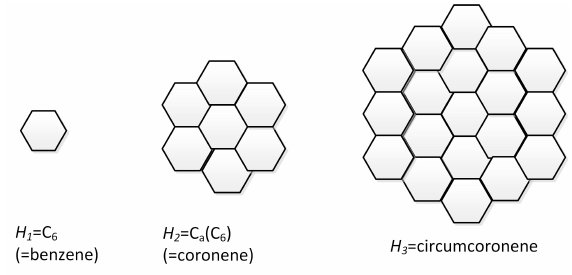
Fig. 2 The structure of H k when k = 1 , 2 ,